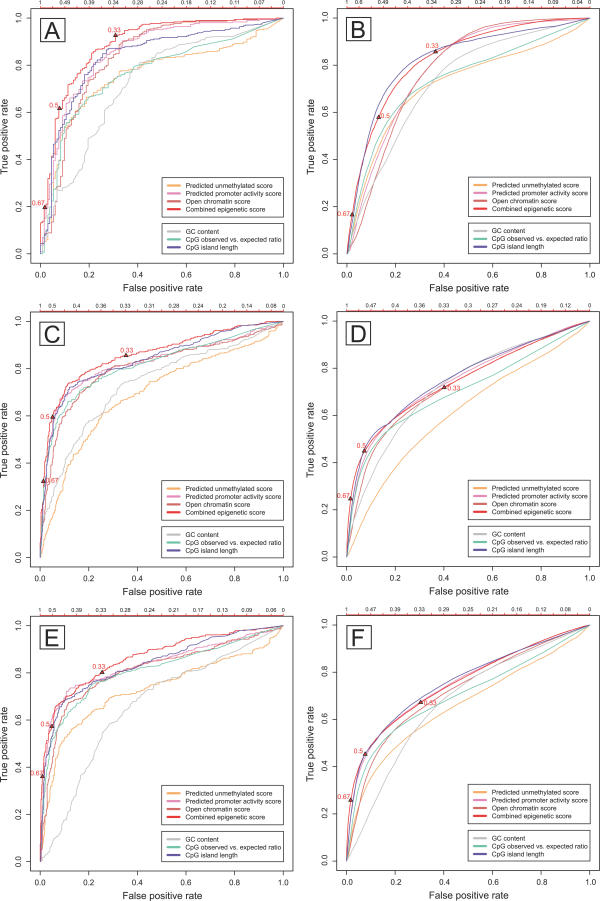
ROC Curves Comparing the Performance of Four Prediction Scores and Three Sequence Criteria against DNA Methylation and Promoter ActivityThis figure compares the prediction performance of four CpG island scores that are based on epigenome prediction (upper legend box) and of three simple sequence criteria (lower legend box). In (A), (C), and (E), overlap with unmethylated regions is used for evaluation, and in (B), (D), and (F), overlap with experimentally determined transcription start sites (as an indicator of promoter activity) is used instead. All graphs plot the true positive rate against the false positive rate in the form of ROC curves [27]. The scales on top of the plots display the threshold values for the combined epigenetic score that correspond to the tradeoff between false positive rate and true positive rate at any one position. The thresholds for the combined epigenetic score are highlighted by triangles: 0.5 (balance between sensitivity and specificity), 0.33 (high sensitivity), and 0.67 (high specificity). Averaged across all six graphs, the ROC area under the curve performance measure (i.e., the percentage of the unit square that lies below the ROC curve [27]) amounts to the following values: predicted unmethylated score, 65.4%; predicted promoter activity score, 74.8%; open chromatin score, 72.2%; combined epigenetic score, 75.8%, GC content, 67.1%; CpG observed-to-expected score, 70.6%; and CpG island length, 75.5%.